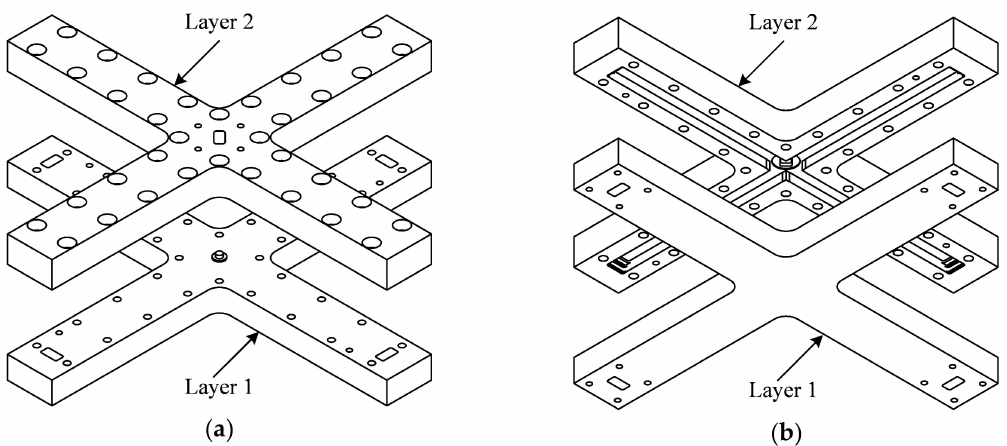
Figure 10. 3D sketch of the designed power divider implemented in layers: ( a ) view from top; ( b ) view from bottom.